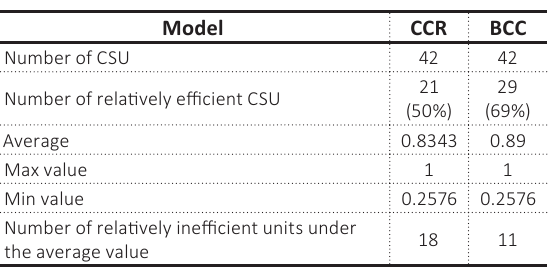
Table 1. General results